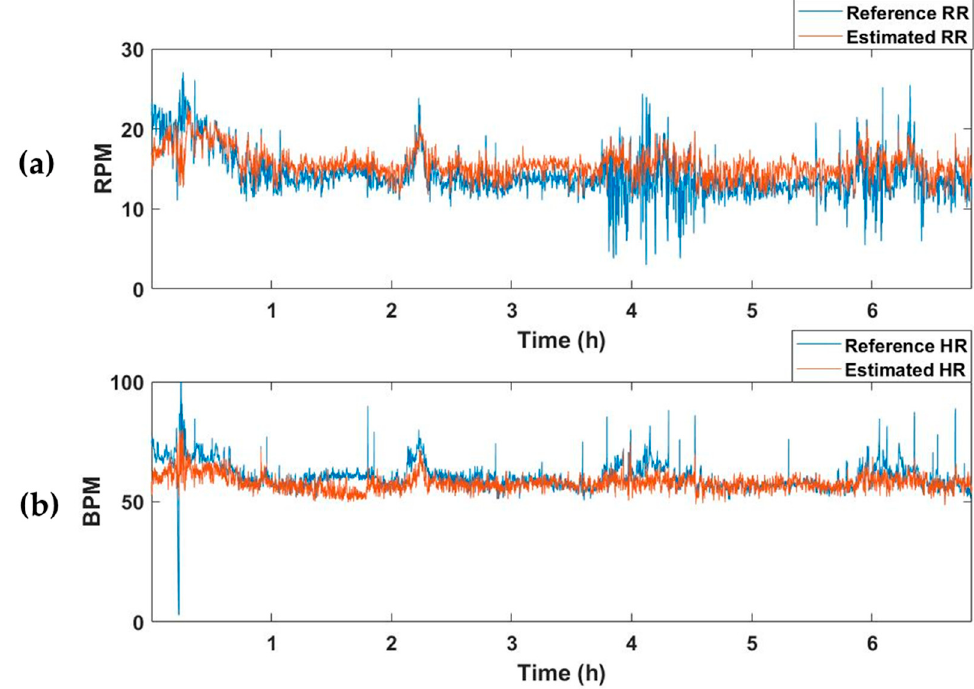
Figure 5. Example of the vital-sign detection results obtained using the vital-signs estimation model. ( a ) Reference and estimated RRs, and ( b ) reference and estimated HRs. RPM, respiration per minute; BPM, beats per